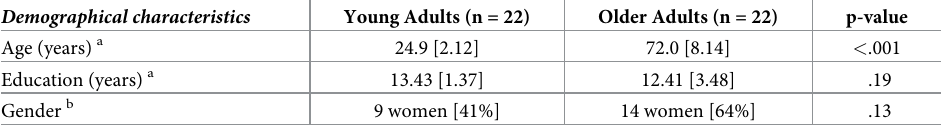
Table 1. Demographic characteristics of